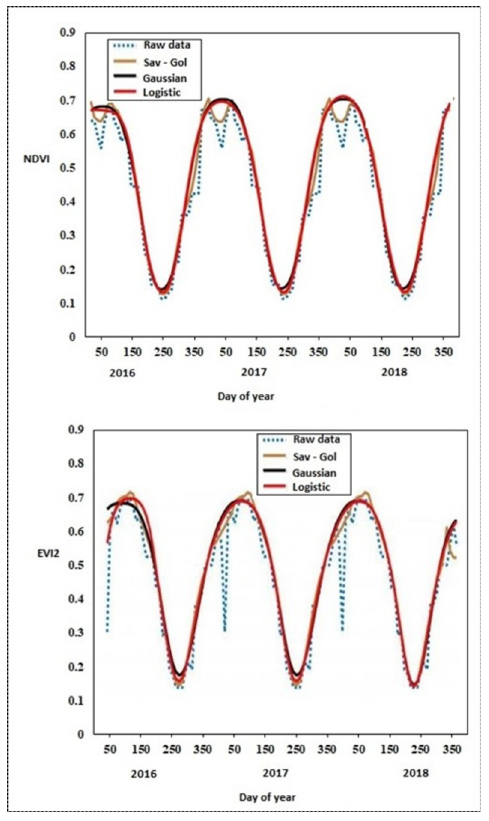
Fig 2. Graphical representation of (a) NDVI and (b) EVI2 raw and fitted time series data computed using SG, DL and AG models for a bracken fern pixel located in Cathedral Peak (29˚13’26.758"E 28˚56’46.2"S).